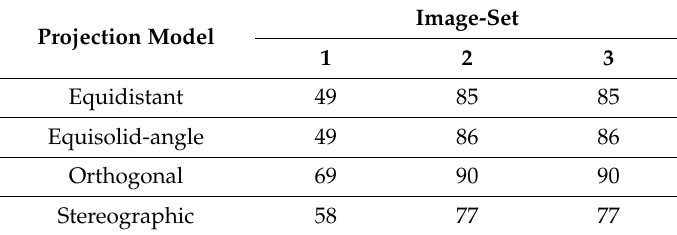
Table 23. Coverage ratio of image points (%).